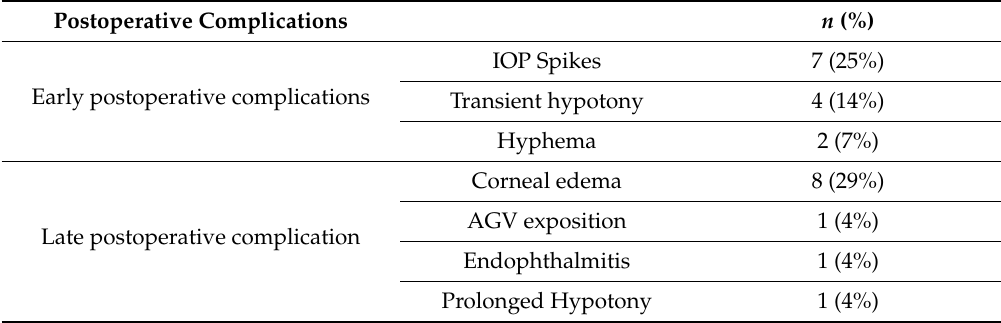
Table 2. Postoperative complications after second Ahmed Glaucoma Valve implantation. Postoperative